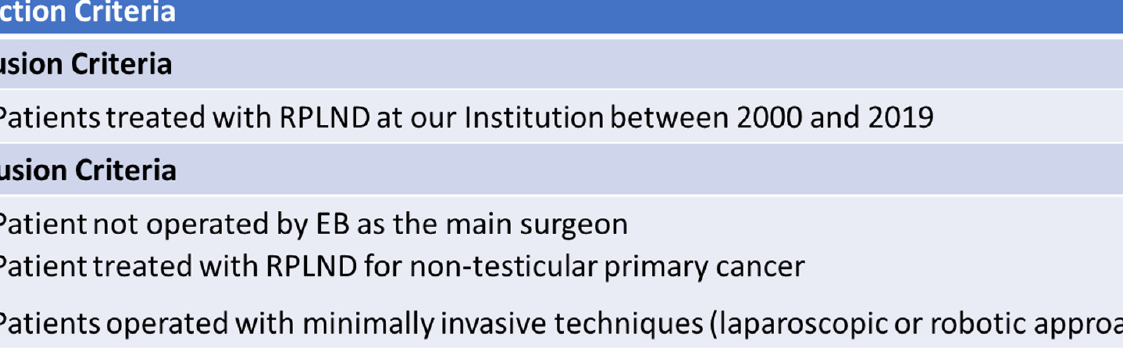
Figure 1. Inclusion and exclusion criteria.